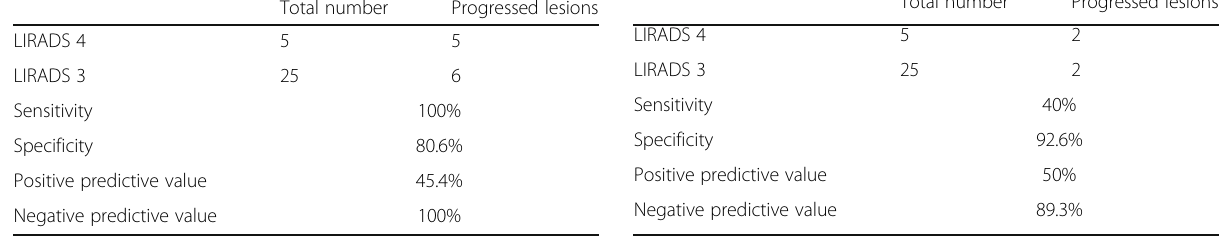
Table 2 Size progression of LI-RADS 4 lesions in the current Table 3 Sensitivity and specificity of progression of less than 2 study compared with LI-RADS 3 with the assessment of cm LI-RADS 4 to LI-RADS 5 by LI-RADS 17 scoring sensitivity and specificity in more than 1 cm NRAP lesions using MedCalc ’ s statistical test Total number